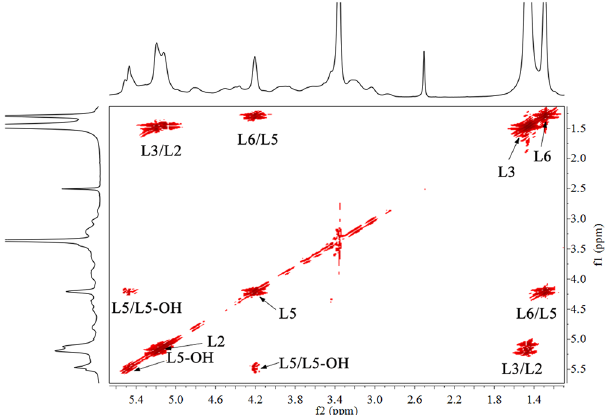
Figure 3. 1 H- 1 H COSY spectrum of xylan- g -PLA copolymer sample 21 (DS = 0.58).